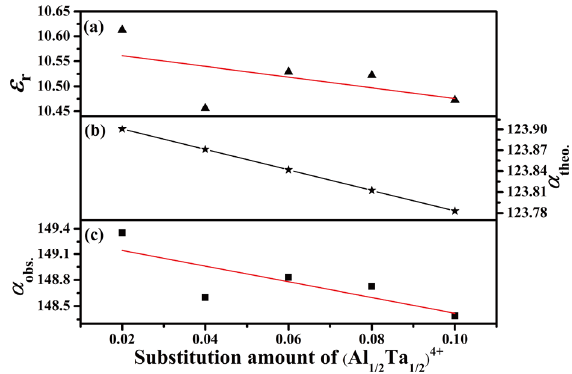
Fig. 9 ɛ r ,  theo . , and  obs . of CZMAT ceramics as a function of x